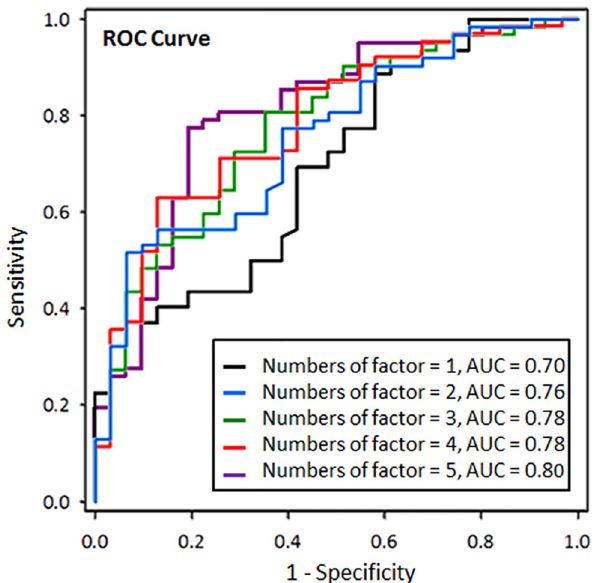
Fig 2. The receiver operating characteristic curves (ROC) of the five normal tissue complication probability models for symptomatic radiation pneumonitis in breast cancer patients treated with hybrid IMRT. Five factors: IV20, energy, age, body mass index (BMI) and T